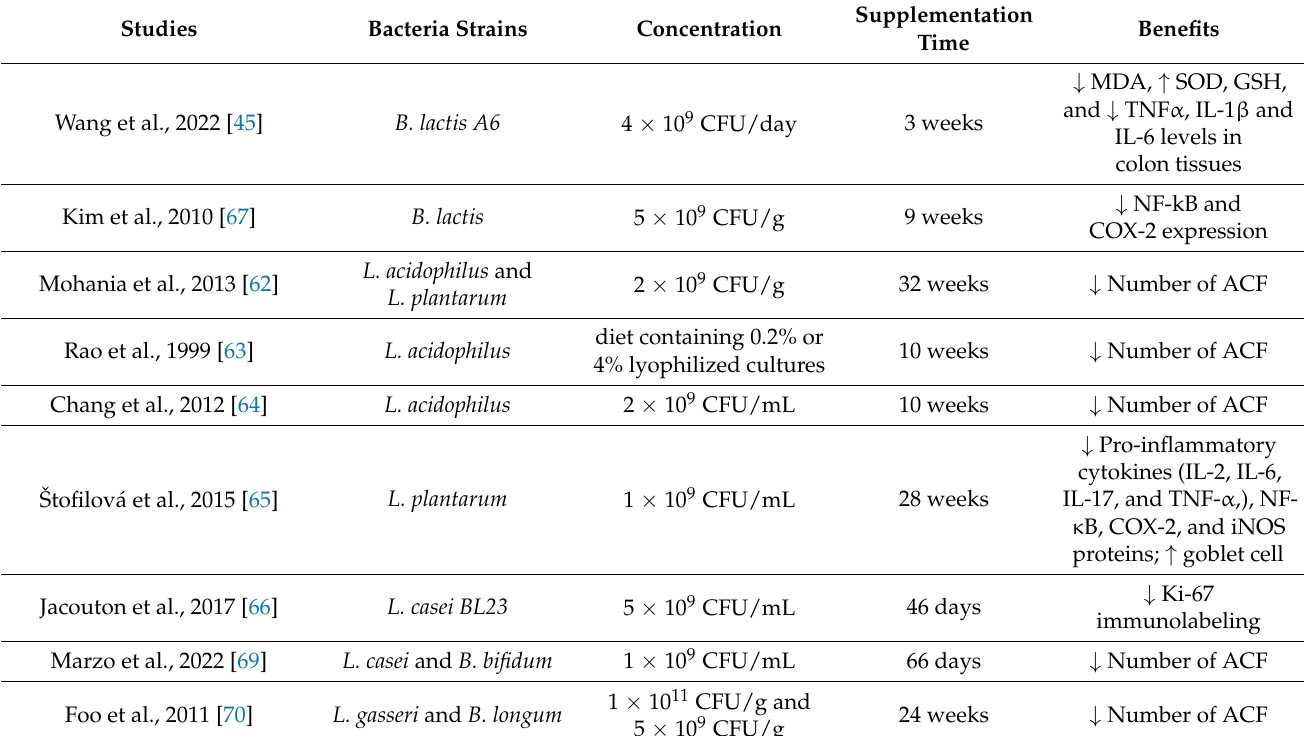
Table 3. Summary of animal model studies of PRO supplementation following CRC